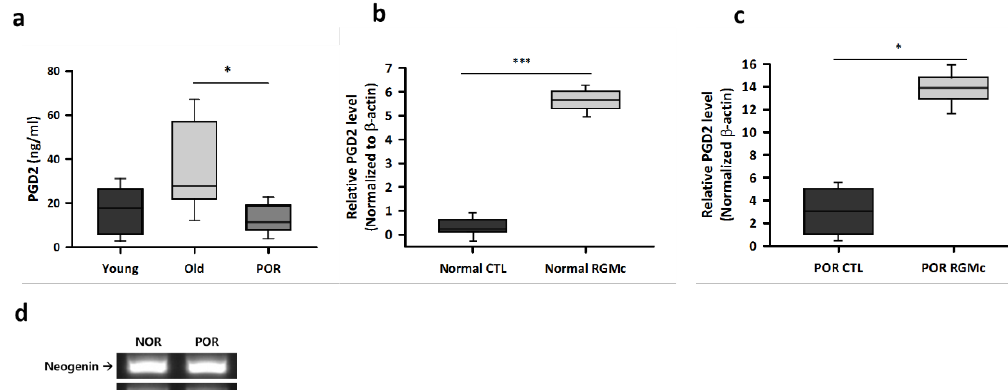
Figure 7. An ELISA of PGD2 in human follicular fluid and the culture medium of RGMc-treated CCs. ( a ) The PGD2 level in follicular fluid of patients with a POR and young and old patients with a normal ovarian response. ( b , c ) The ELISA data of PGD2 level in the culture media of RGMc-treated CCs obtained from ( b ) patients with a normal ovarian response and ( c ) patients with a POR. ( d ) Gene expression of neogenin in human CCs of normal and POR patients. All assays were repeated three times with different samples for statistical analysis. * p < 0.05 and *** p < 0.001 versus the young and old normal ovarian response groups.